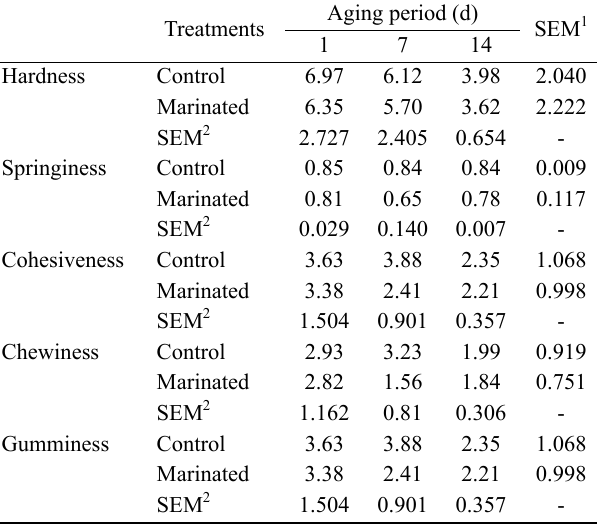
Table 7. Effect of aging and marination on texture profile analyses of duck breast meat